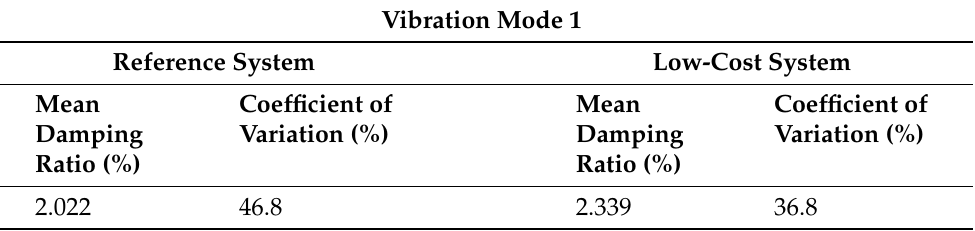
Figure 22. Free vibration response of the two-story structure for DOF 2: ( a ) Exponential free-decay window. ( b ) Representative acceleration peaks from the filtered free-vibration signal of the ADXL355 RBP3 accelerometer. Table 8. Mean damping ratios and coefficients of variation calculated for both monitoring systems.